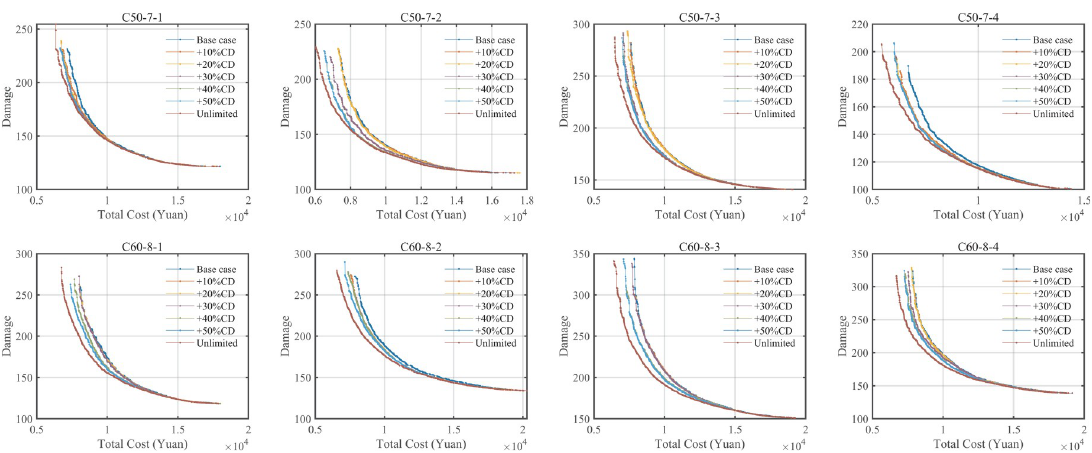
Fig 8. Pareto fronts of seven variants of depot